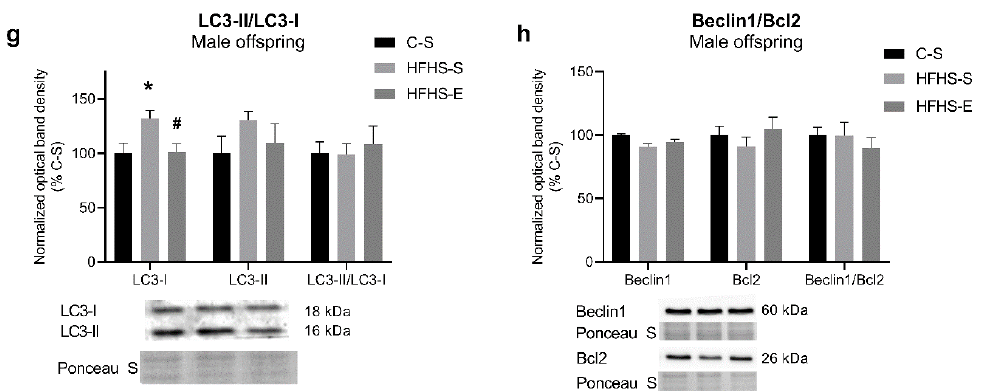
Figure 5. Effects of maternal HFHS and GE on the protein expression of different markers of auto(mito)phagy signalling in liver and liver mitochondria in mothers: ( a ) relative content of PINK1, ( b ) relative content of Parkin, ( c ) relative content of LC3-I and LC3-II and their ratio, ( d ) relative content of Beclin1 and Bcl2 and their ratio; and in offspring: ( e ) relative content of PINK1, ( f ) relative content of Parkin, ( g ) relative content of LC3-I and LC3-II and their ratio, ( h ) relative content of Beclin1 and Bcl2 and their ratio. GE—gestational exercise; C—mothers fed with control diet; HFHS—mothers fed with high-fat high-sucrose diet; S—sedentary mothers; E—exercised mothers. * vs. P-C-S ( p < 0.05) or vs. C-S ( p < 0.05) in mothers or offspring, respectively. # vs. P-HFHS-S ( p < 0.05) or vs. HFHS-S ( p < 0.05) in mothers or offspring,